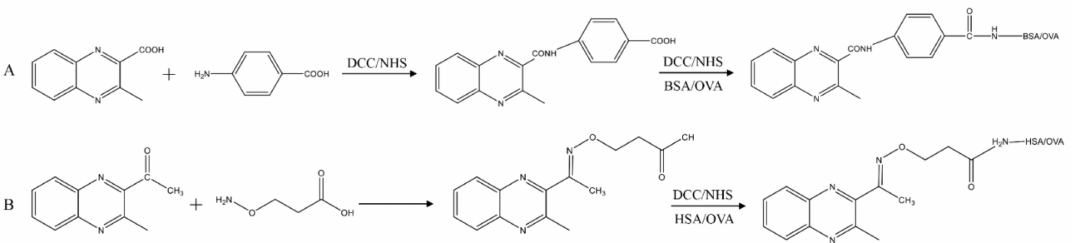
Figure 2. The synthesis protocol of MQCA–PABA–BSA/OVA ( A ) and DMEQ–AOAA–HSA/OVA ( B